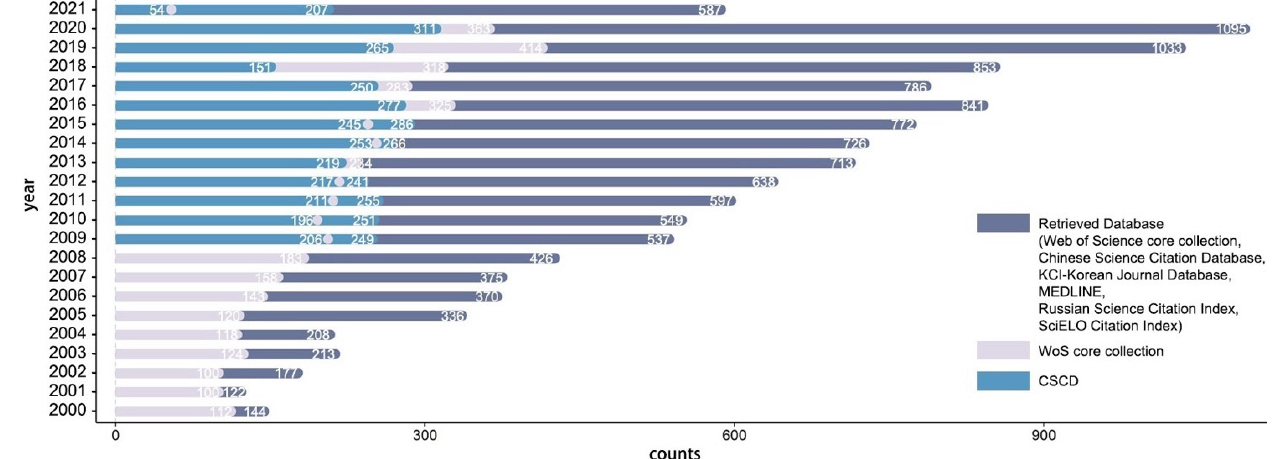
Figure 3. The annual number of articles. The related literature was searched for in the database from January 2000 to September 2021.